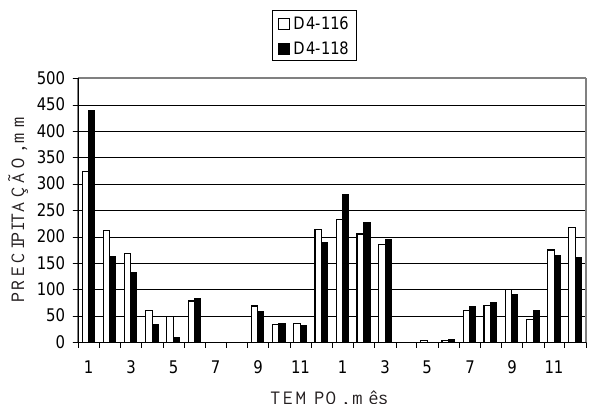
Figura 4. Distribuição temporal da precipitação nos dois postos pluviográficos instalados na MHRM.